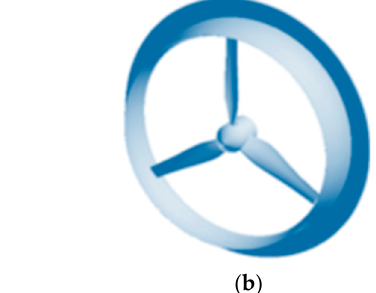
Figure 1. Wind lens turbine (WLT) mechanism. Figure 2. Representative shapes of WLTs: ( a ) Prototype; ( b ) Compact type.